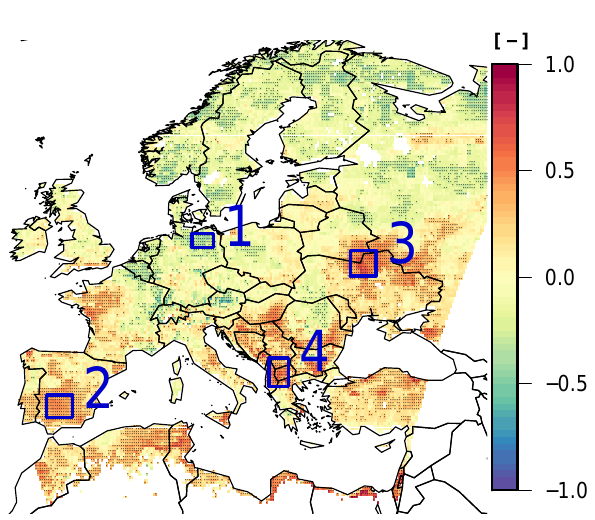
Figure B1. Ecosystem vulnerability to S as in Fig. 4a with marked areas 1 to 4, for which components of carbon fluxes in hazard and non-hazard group are shown.